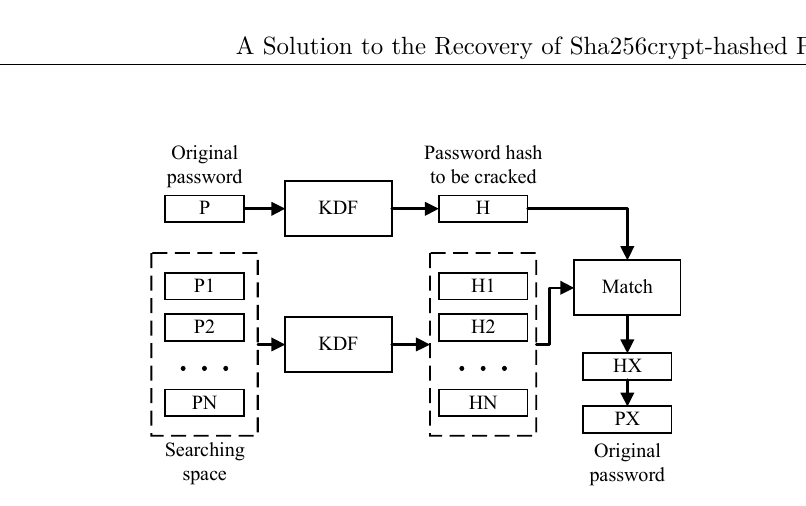
Figure 1: A typical diagram of the brute-force attack. The original password P is encrypted by the KDF to generate a password hash H . The attacker applies KDF to all passwords in the searching space and matches every generated hash with the password hash H . If HX matches the password hash H , the original password PX is retrieved.